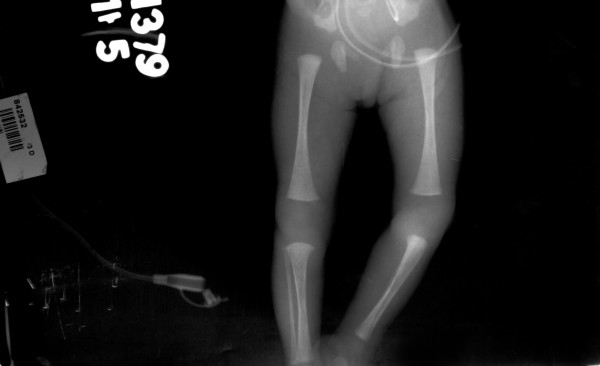
Radiological examination for bone showing absence of epiphysis at the lower end of femur and upper end of tibia in Twin A.